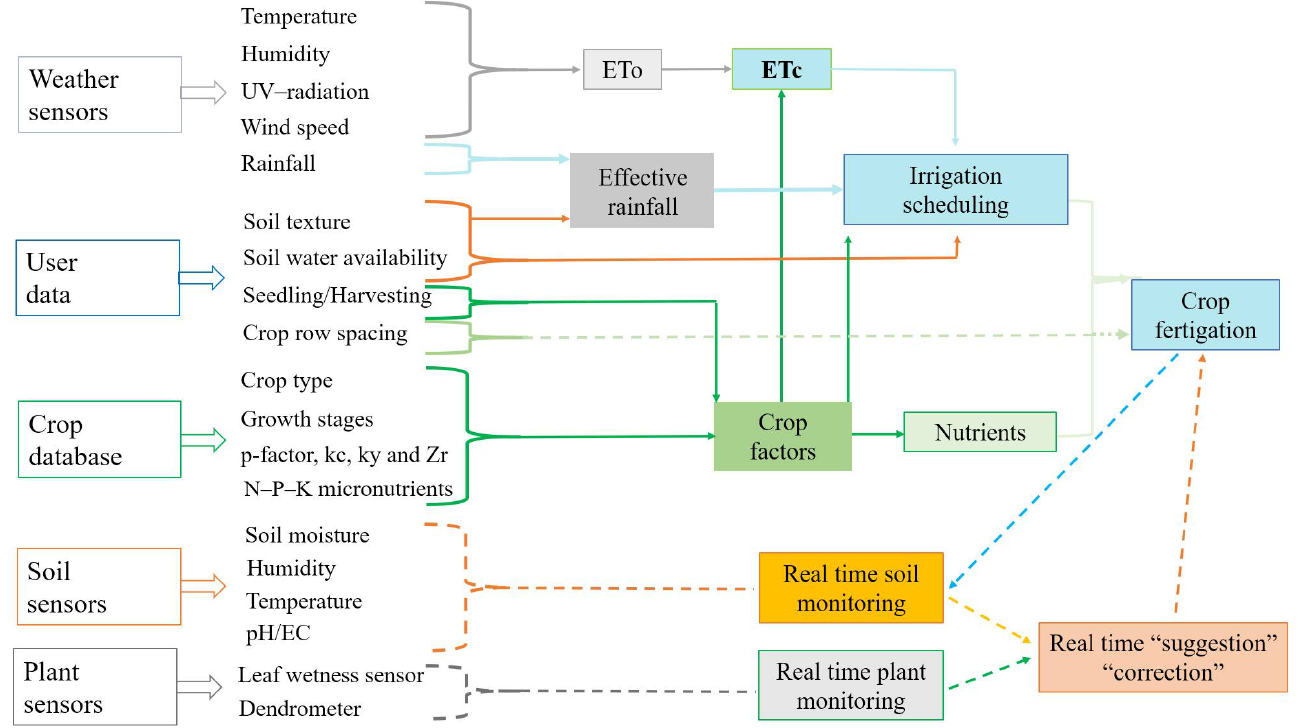
Figure 2. Flow diagram of functions of the proposed system. Note: ETo = reference evapotranspiration; ETc = crop evapotranspiration; p = depletion factor; kc = crop coefficient; ky = yield factor; Zr = root depth; N = nitrogen; P = phosphorus; K = potassium; and EC = electrical conductivity.